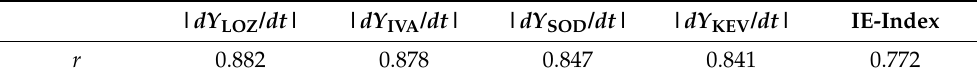
Table 3. Correlation of the values | J VKH | with values of geomagnetic variations (data averaged over 15 min